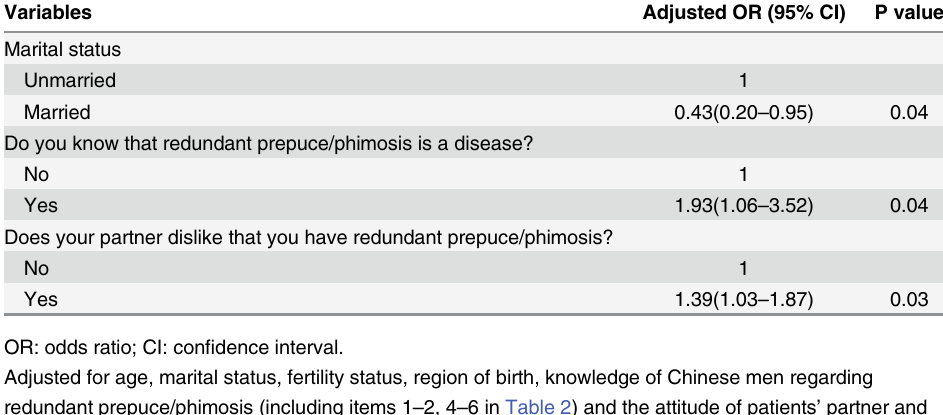
Table 6. Multivariable analysis of